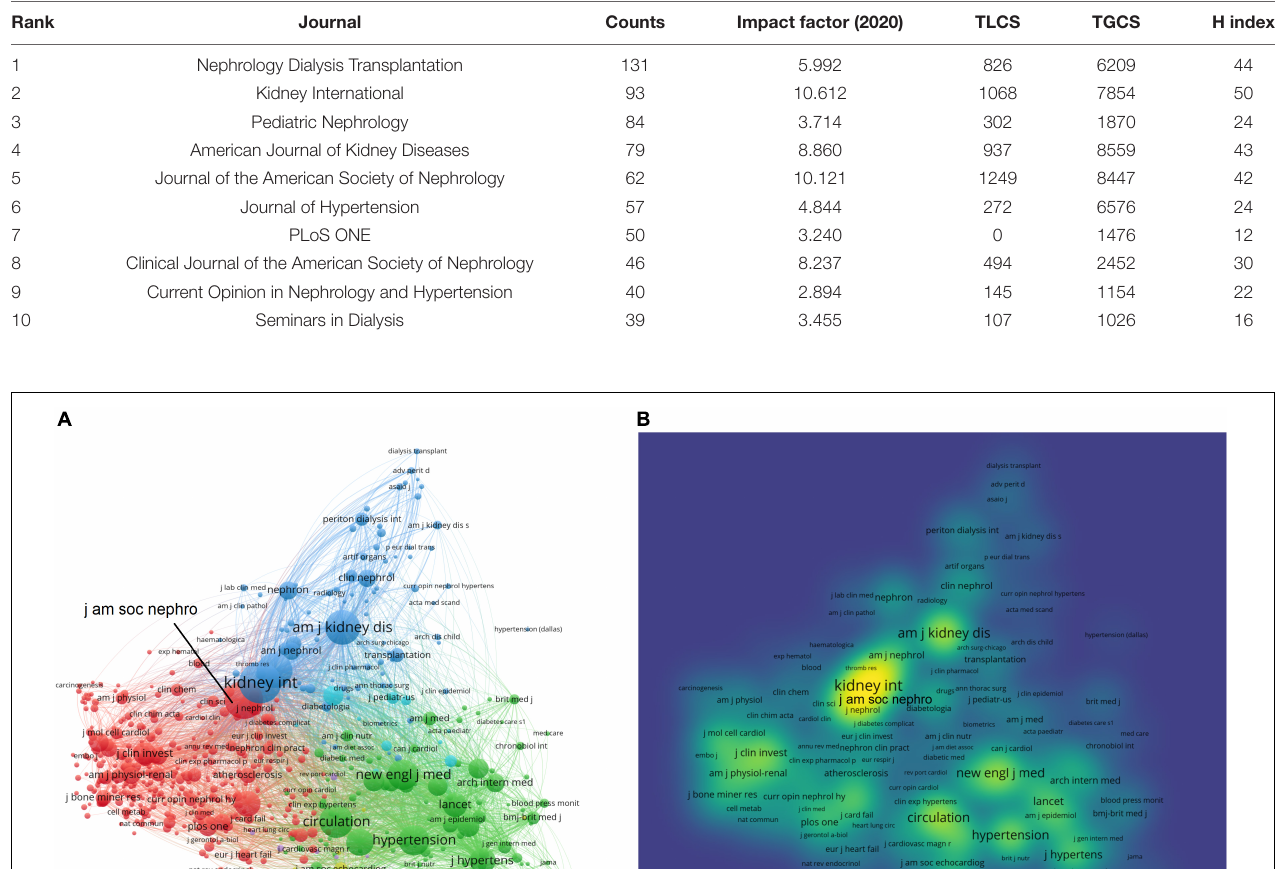
TABLE 4 | The top 10 journals concerning uremic cardiomyopathy.